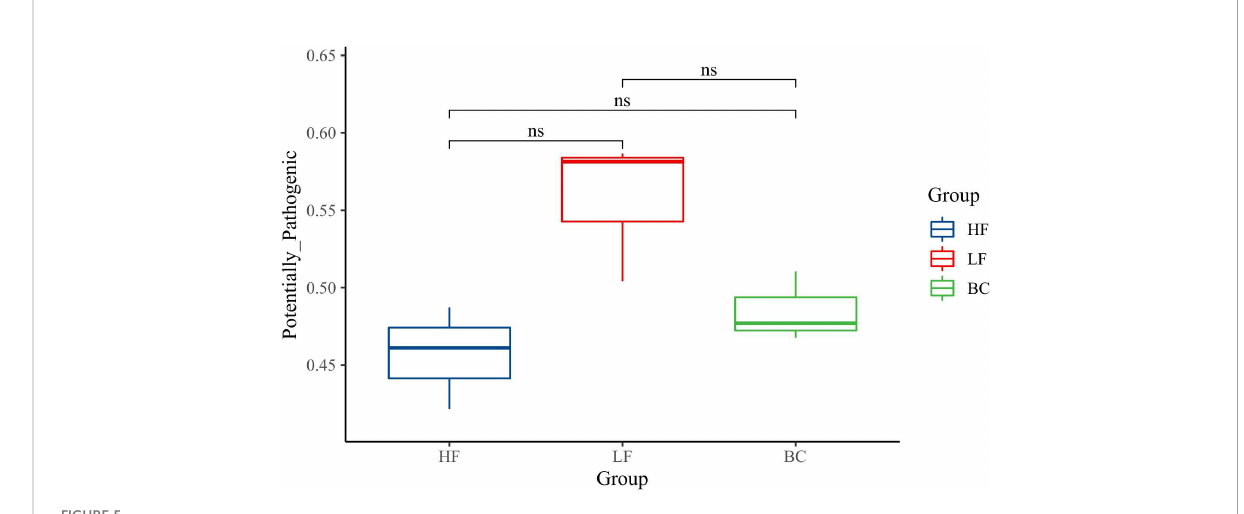
FIGURE 5 Gut microbiota function prediction. ns, P >